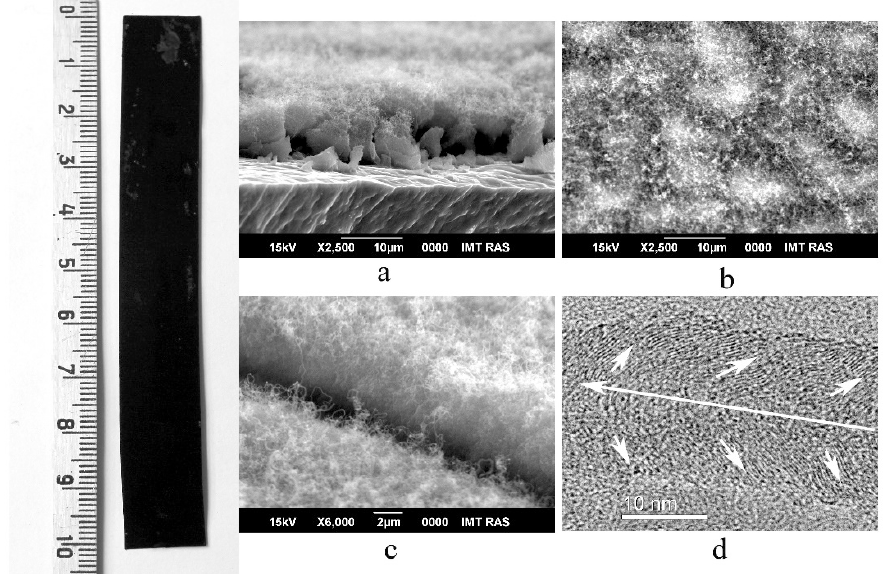
Figure 1. Left: a photograph of an MWCNT/Al foil strip; scanning electron micrographs of MWCNT/Al foil: ( a ) cross section, ( b ) top view, ( c ) a 45° view, and ( d ) transmission electron micrograph of individual MWCNT.